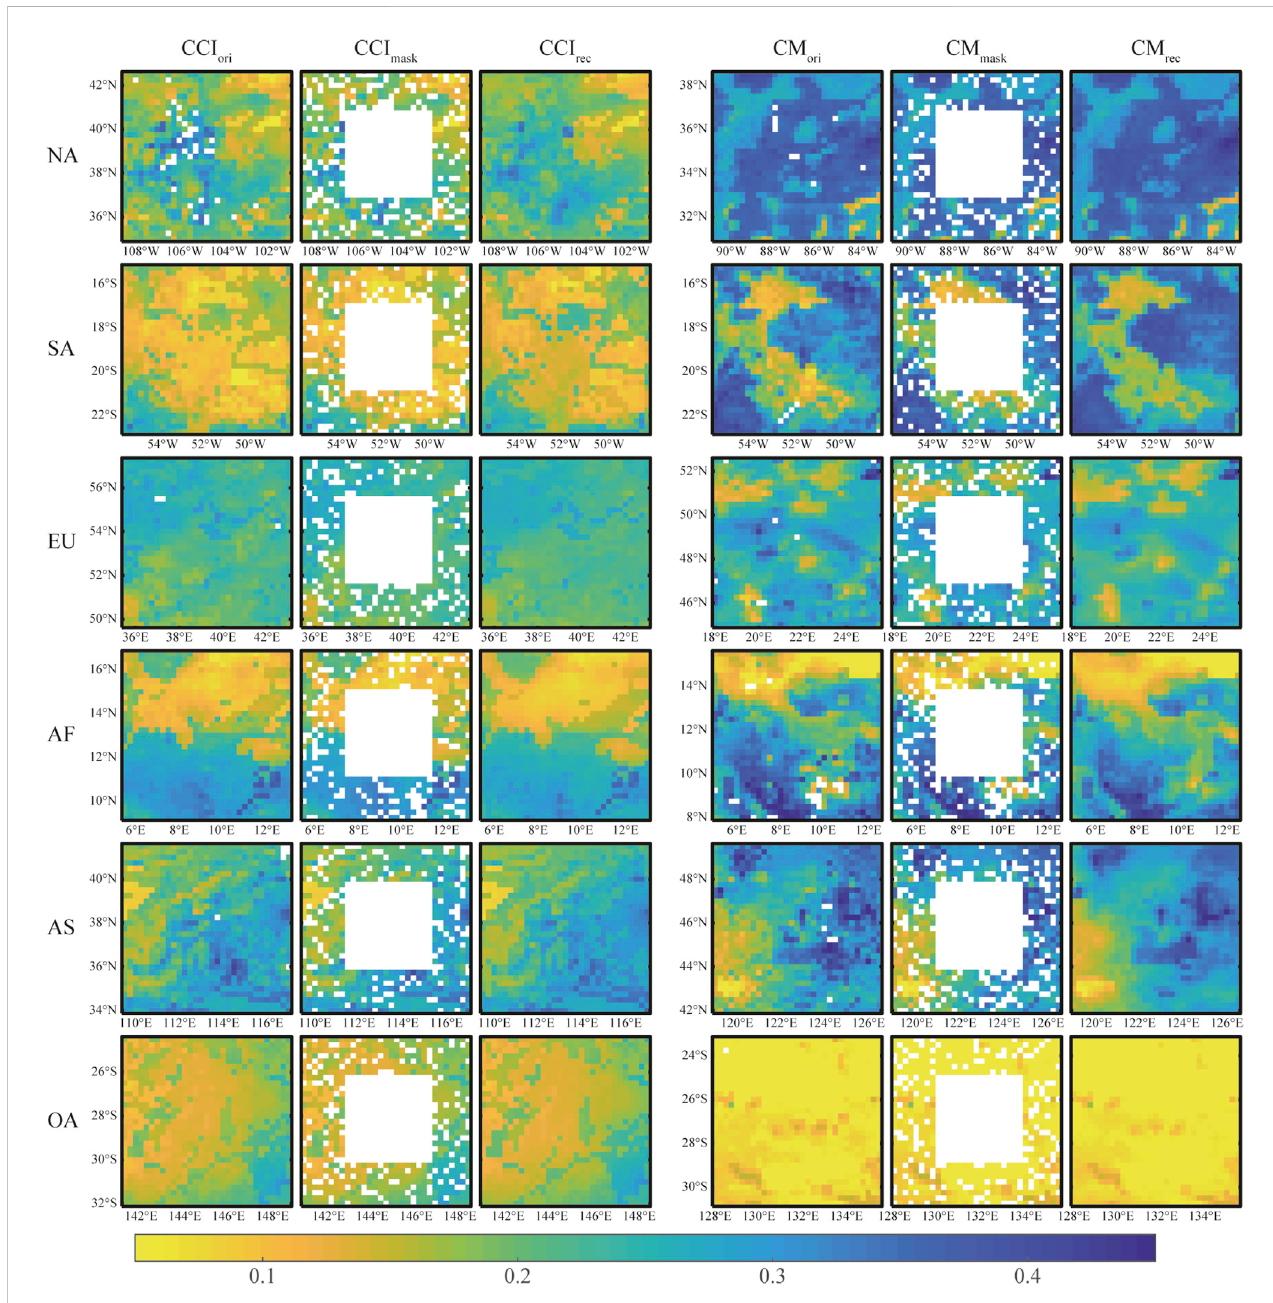
FIGURE 5 Selected regions with random and rectangular arti fi cial missing values and their respective reconstructions (unit: m 3 /m 3 ).